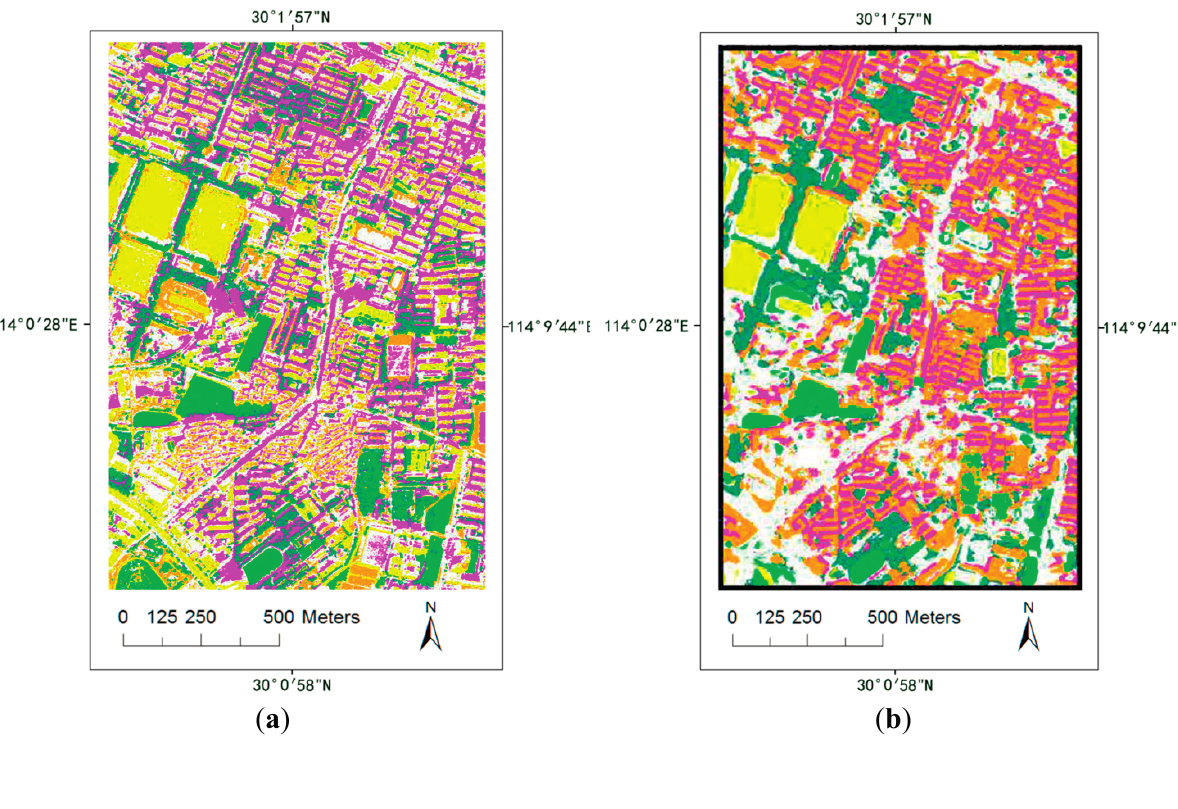
Figure 3. SVM classification results of the GeoEye-1 Wuhan dataset by ( a ) the original multispectral image; ( b ) All-GLCM with a quantization level of 16; ( c ) PCA-GLCM with a quantization level of 16; ( d ) K-means GLCM with a quantization level of 64; ( e ) S-GLCM (1) with a quantization level of 8; ( f ) C&S-GLCM with a quantization level of